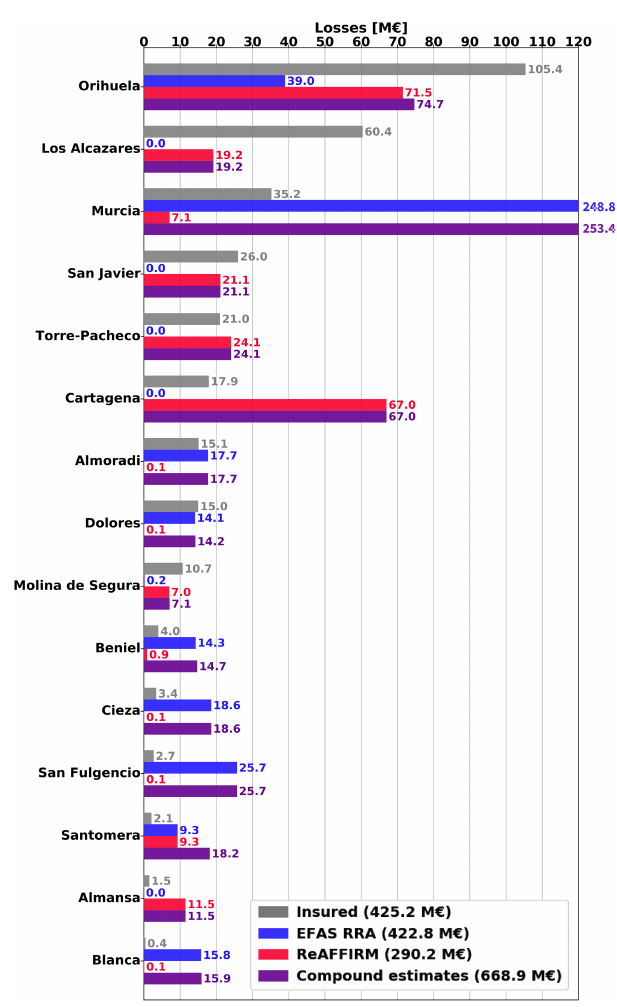
Figure 9. Comparison of insured losses (CCS, 2020) with those estimated by the two individual methods (Sect. 4.1 and 4.2) and the compound impact estimation (Sect. 4.3) in the 15 municipali- ties with insured or simulated losses greater than EUR10 million (corresponding to Table 4).